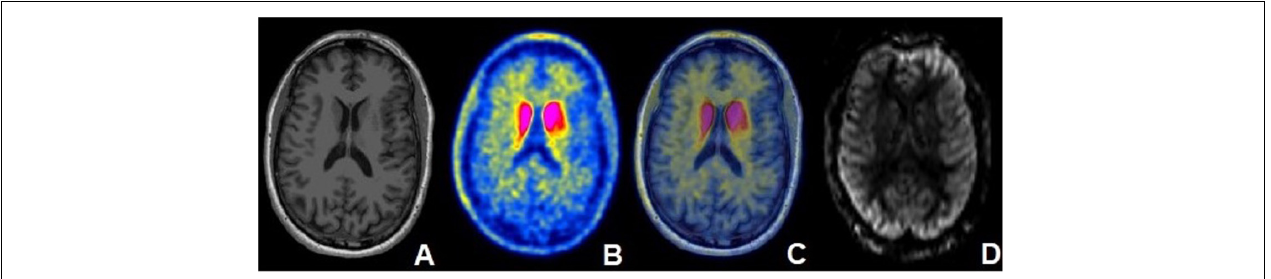
FIGURE 1 | Fifty five year old male with PD diagnosed 5 years ago with moderate disease based on MDS-UPDRS part 3 (motor) "off" score and associated mild cognitive impairment. (A) Axial T1-weighted MRI demonstrating no structural abnormalities. (B) Axial [11C]-PE2I PET image and (C) fused axial [11C]-PE2I PET/MR